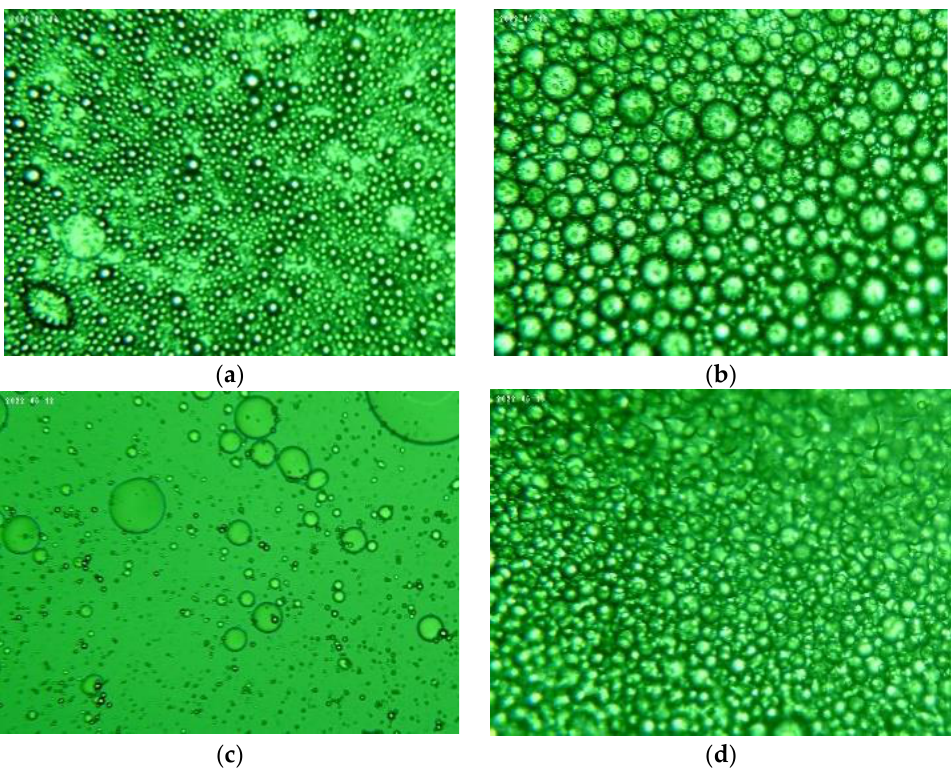
Figure 1. Microscopic images of oil-in-water emulsions containing oregano extract — ( a ) exp. No. 7; ( b ) exp. No. 9 — and oil-in-water emulsions containing rosemary extract ( c ) exp. No. 9; ( d ) exp. No. 10.